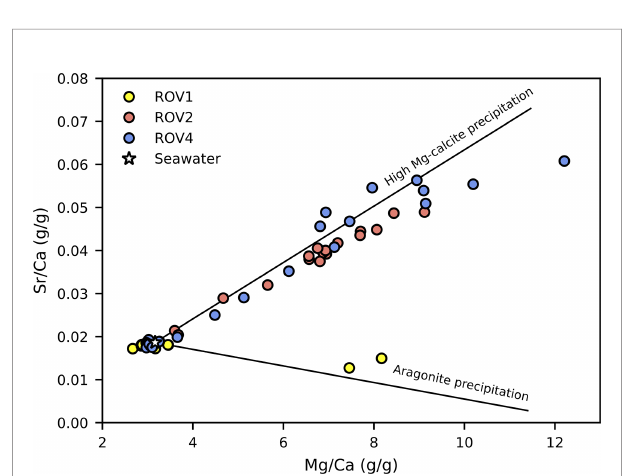
FIGURE 5 | Plot of Sr/Ca versus Mg/Ca (weight ratios) in pore water of cores ROV1, ROV2, and ROV4 as well as in seawater (de Villiers, 1999). The two bold lines indicate changes in the Sr/Ca to Mg/Ca relationship in pore water with respect to the composition of seawater that occur during precipitation of either aragonite or high Mg-calcite. The Sr/Ca and Mg/Ca ratios of the precipitating aragonite and high Mg-calcite were taken from Bayon et al. (2007) and Nöthen and Kasten